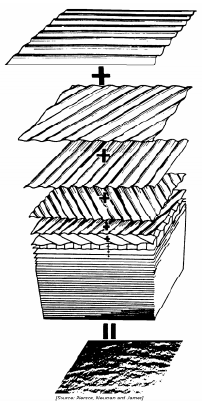
Figure 3. Superposition of different regular waves, from